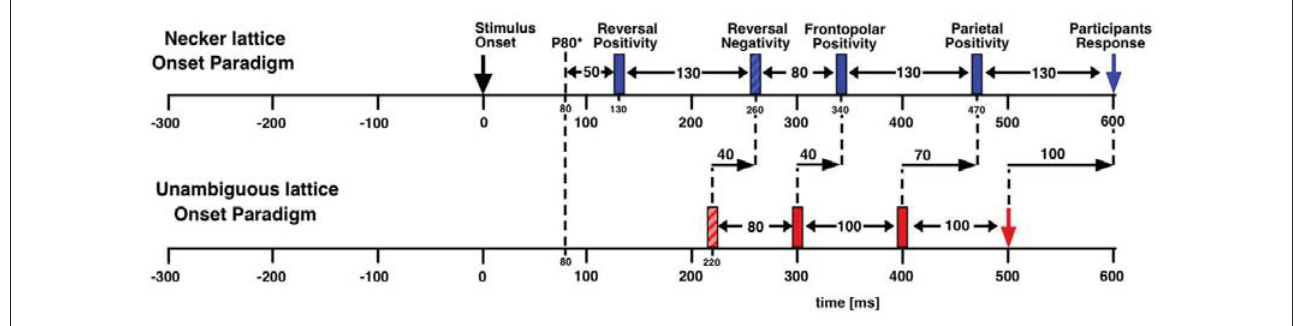
FIGURE 8 | Schematic time scale of endogenous and exogenous dERP components. dERP components are indicated by rectangles.The vertical dashed line indicates the P100 as earliest occipital ERP